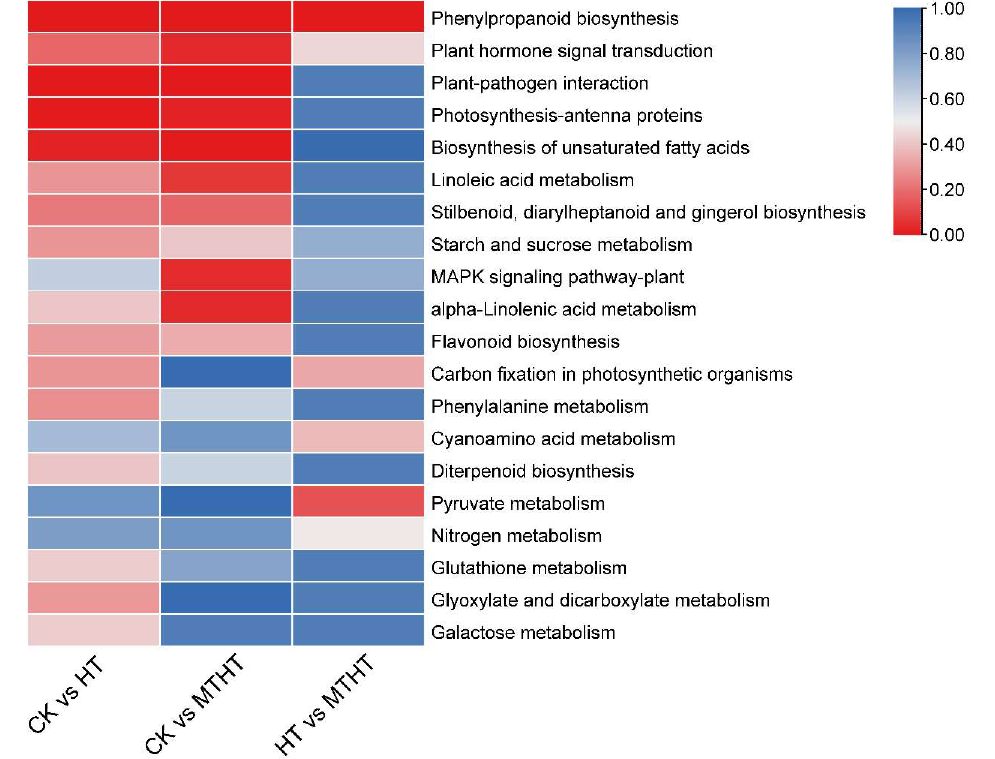
Figure 6. Kyoto Encyclopedia of Genes and Genomes (KEGG) enrichment analysis of DEGs among comparison pairs. The plot is drawn based on the q value of the enrichment in the pathway, and a redder color indicates that the enrichment is more pronounced. The first 20 enrichment pathways are represented. Significant DEGs are identified based on a false discovery rate (FDR) ≤ 0.05 and a |log2 ratio| ≥ 1).